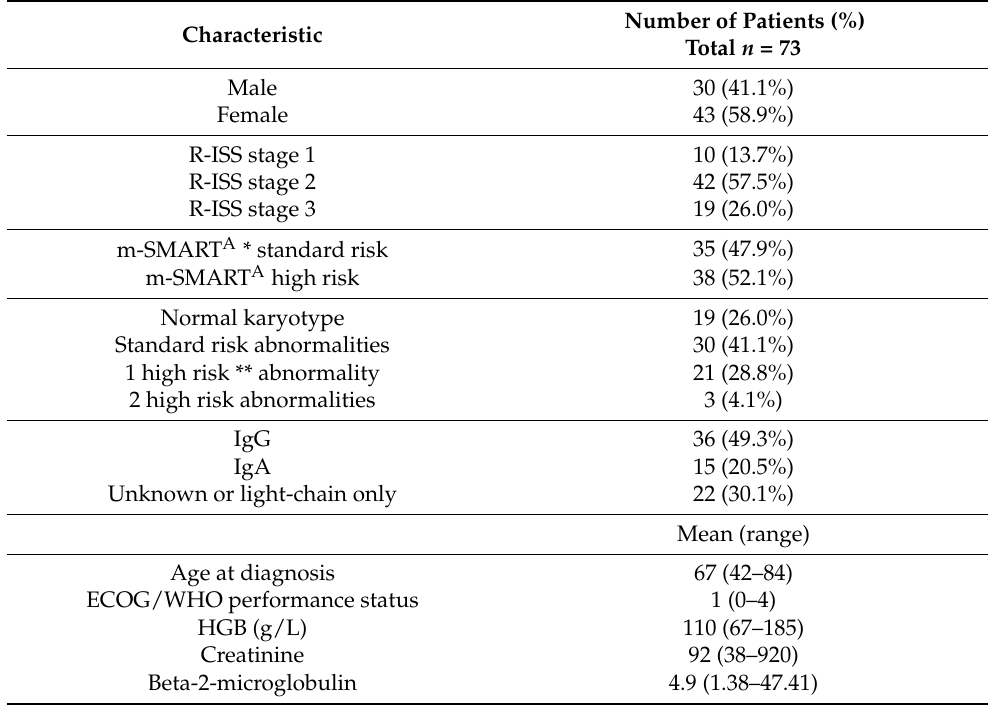
Table 1. Patient characteristics with categorical variables as percentages and continuous variable mean and range